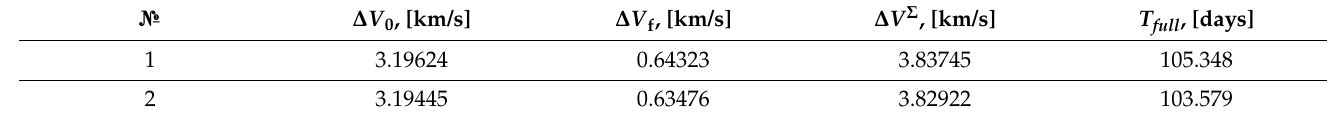
Table 2. The comparison between solutions of the main problem (bold) and the auxiliary